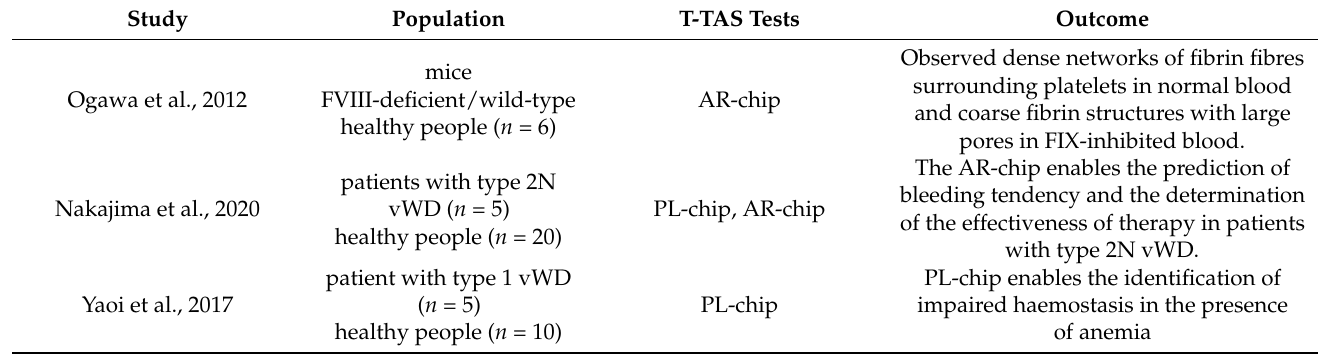
Table 3. Comparison of studies on the application of T-TAS in bleeding (AF—atrial fibrillation, ARC-HBR—Academic Research Consortium for High Bleeding Risk, AR4-AUC30—area under the flow pressure curve for the first 30 min for AR-chip tested at flow rate of 4 µ L/min, AR10-AUC30—area under the flow pressure curve for the first 30 min for AR-chip tested at flow rate of 10 µ L/min, CAD—coronary artery disease, CAG—coronarography, CF-LVAD—continuous-flow left ventricular assist device, eGFR—estimated glomerular filtration rate, FVIII—factor VIII, FIX—factor IX, HF—heart failure, NOAC—novel oral anticoagulants, PCI—percutaneous coronary interventions, PFDs—platelet function disorders, PL24-AUC10—area under the flow pressure curve for the first 10 min for PL-chip tested at flow rate of 24 µ L/min, vWD -von Willebrand